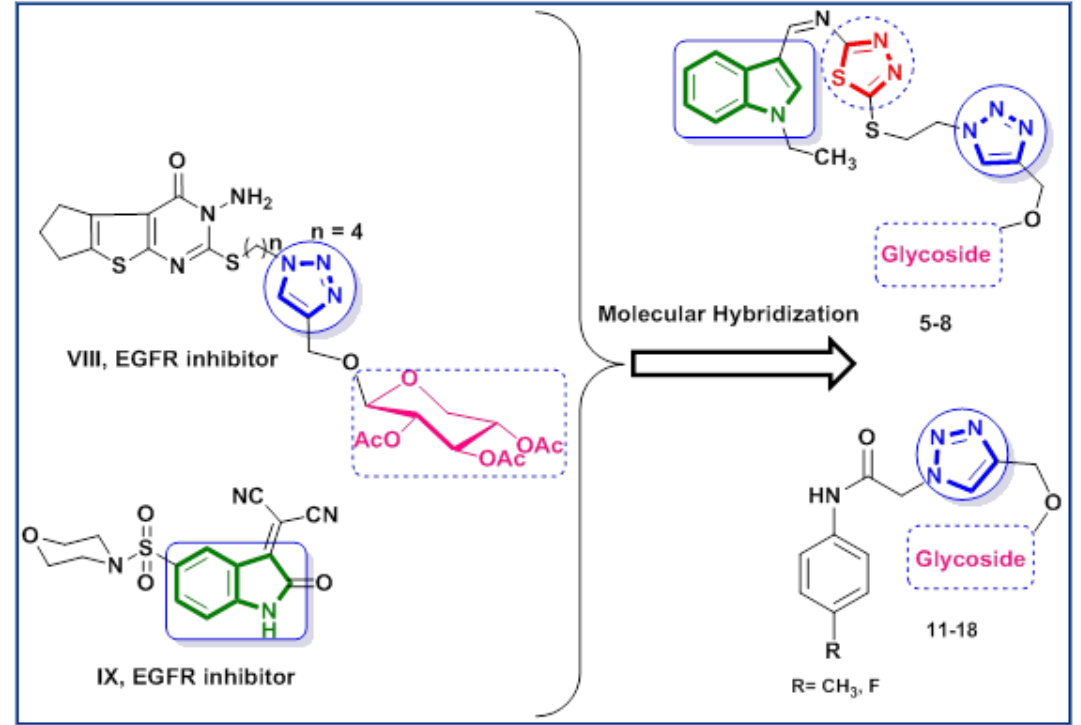
Figure 2. Reported EGFR inhibitors and the design concept of glycosides linked to indole–thiadiazole–triazole bases or substituted arylacetamino–triazole hybrids.